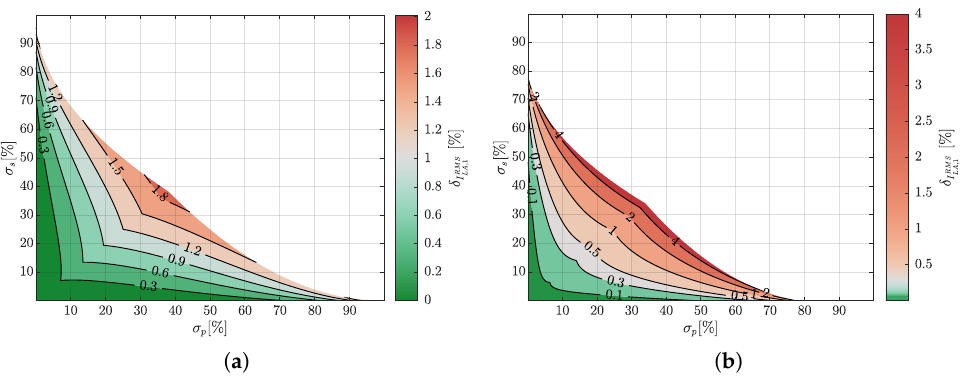
= − 2.5% on points P σ ,opt